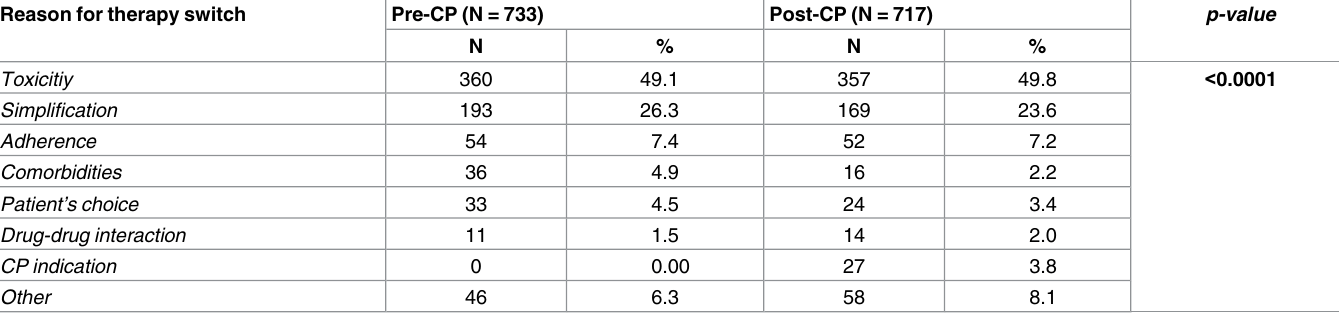
Table 2. Reasons for therapy switch at baseline in patients who switched for Toxicity/other, Lombardy Region, Italy, comparing Pre-CP (2009– 2010) and Post-CP (2011–2012). Reason for therapy